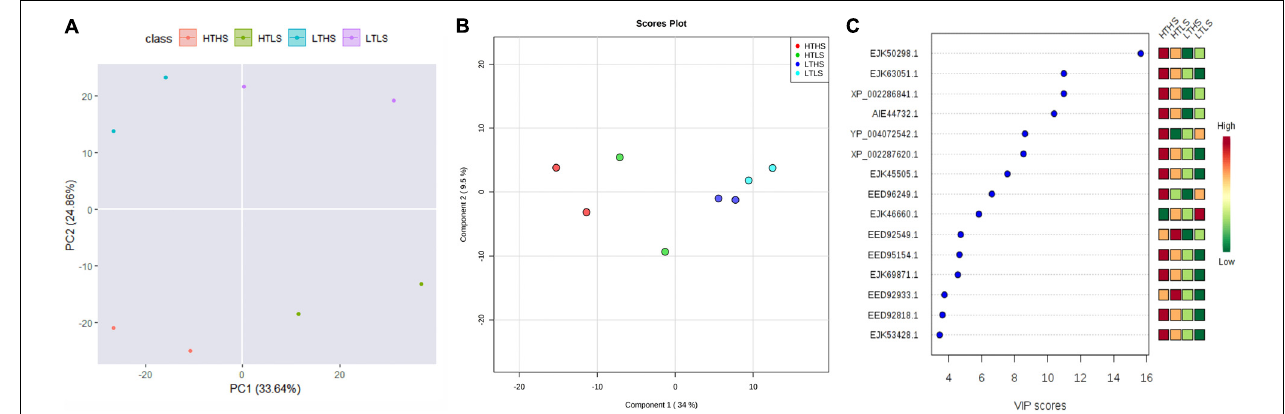
FIGURE 4 | The multivariate statistical analysis score plots on S. dohrnii proteins quantified across all eight samples. (A) Scatter plot of the first two principal component analysis (PCA) of diatom S. dohrnii iTRAQ data. (B) PLS-DA score plot analysis obtained from diatom S. dohrnii. (C) Variable Important in Projection (VIP Score plot) the estimation of important variables in the projection used in PLS-DA model.